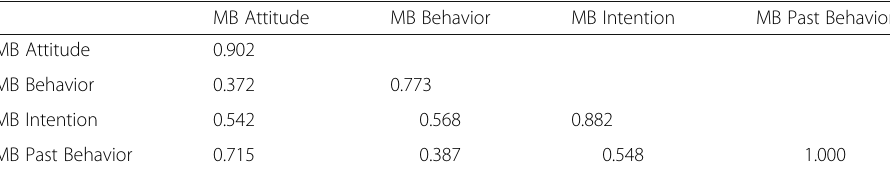
Table 4 Fomell-Larcker criterion